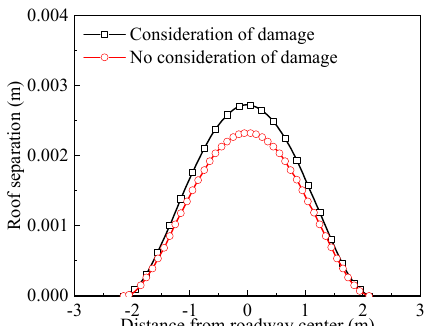
Figure 13. Influence of bolt support on composite roof separation.